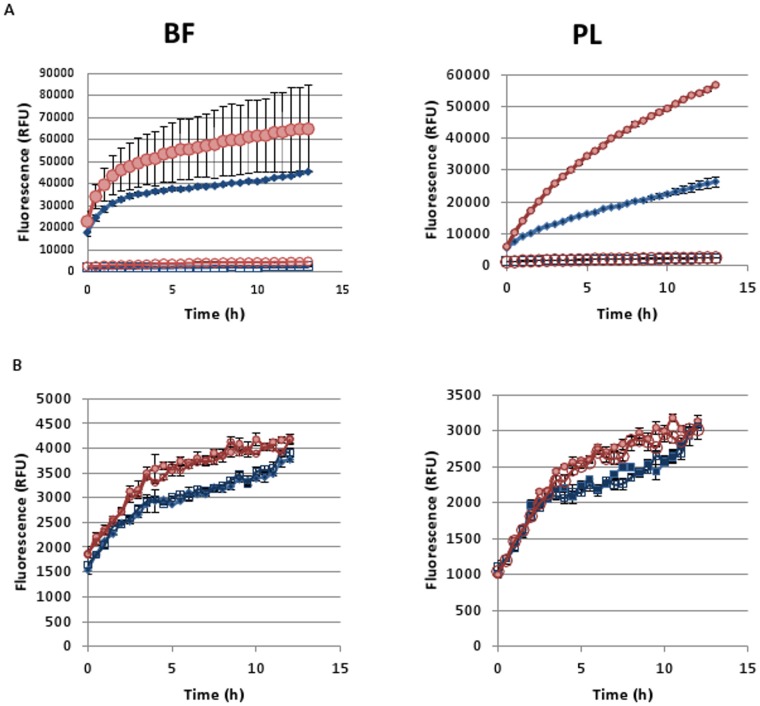
Fluorescence generated over time in treated (4 x MIC, up to 13 h) (red circles) and untreated (blue squares) biofilms (left) and planktonic cultures (right).(A) Cultures incubated with (closed circles and squares) or without (open circles and squares) H2DCFDA. (B) Cultures incubated with (closed circles and squares) or without (open circles and squares) HPF. Data are shown of a single representative experiment. Error bars represent SEM (calculated on 3 technical replicates).